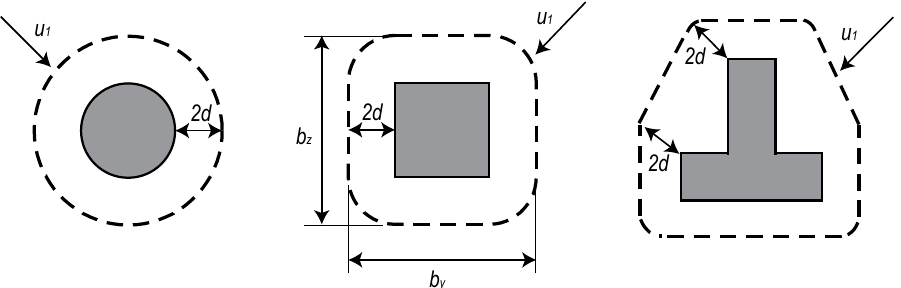
Figure 2. Typical critical control sections around load introduction areas according to DIN EN 1992 ‐ 1 ‐ 1 [4,5].